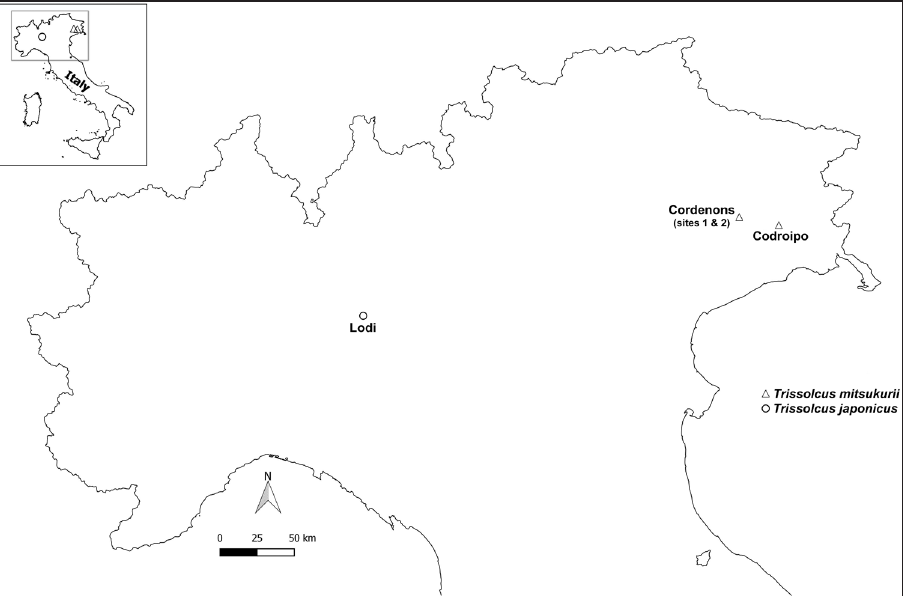
Figure 1. Recovery sites of Trissolcus mitsukurii and Trissolcus japonicus in northern Italy. Table 2. Parasitism of Halyomorpha halys eggs by Trissolcus mitsukurii collected in field surveys of August 7–8, 2018, in northeastern Italy.